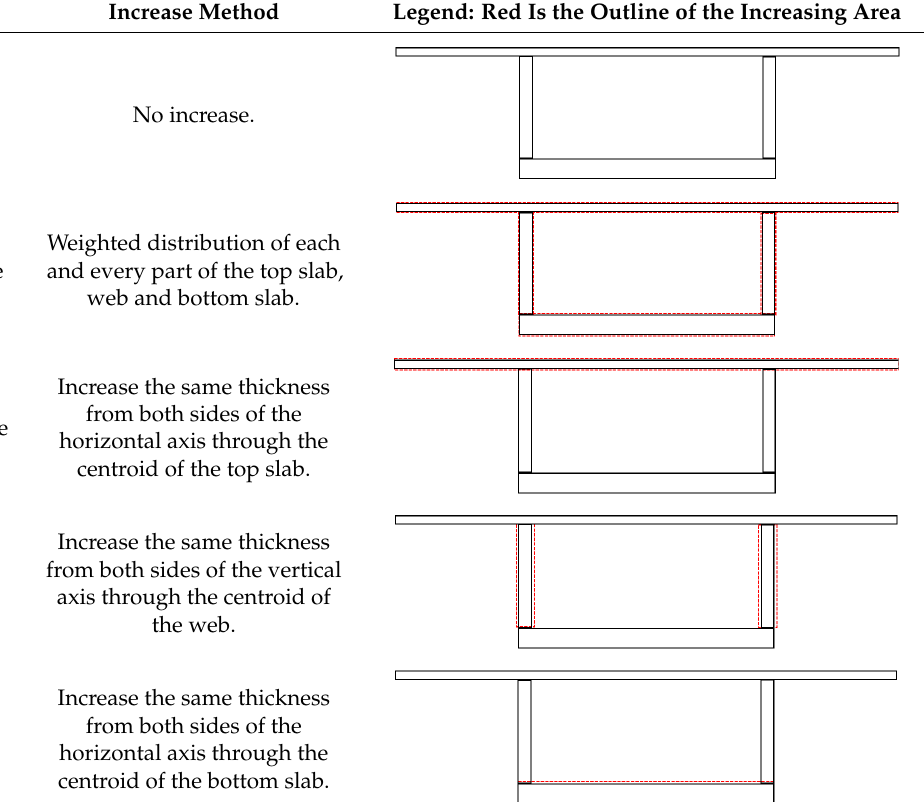
Table 1. Detailed description of comparison models and benchmark model.